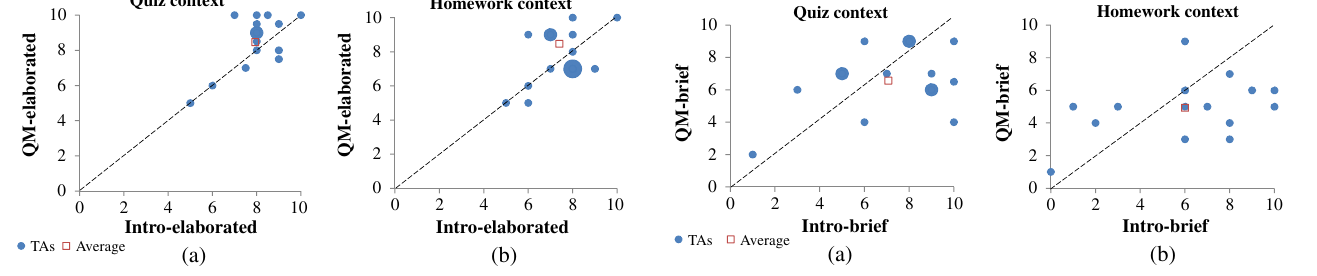
FIG. 7. (a) Distribution of individual scores assigned to the brief solutions QSS-B (QM) versus ISS-B (Intro) versus QSS-B (QM) in the quiz context ( p ¼ 0 . 574 ). (b) Individual scores assigned to QSS-B (QM) versus ISS-B (Intro) in the HW context ( p ¼ 0 . 273 ). The size of the bubble represents the number of TAs ( N ¼